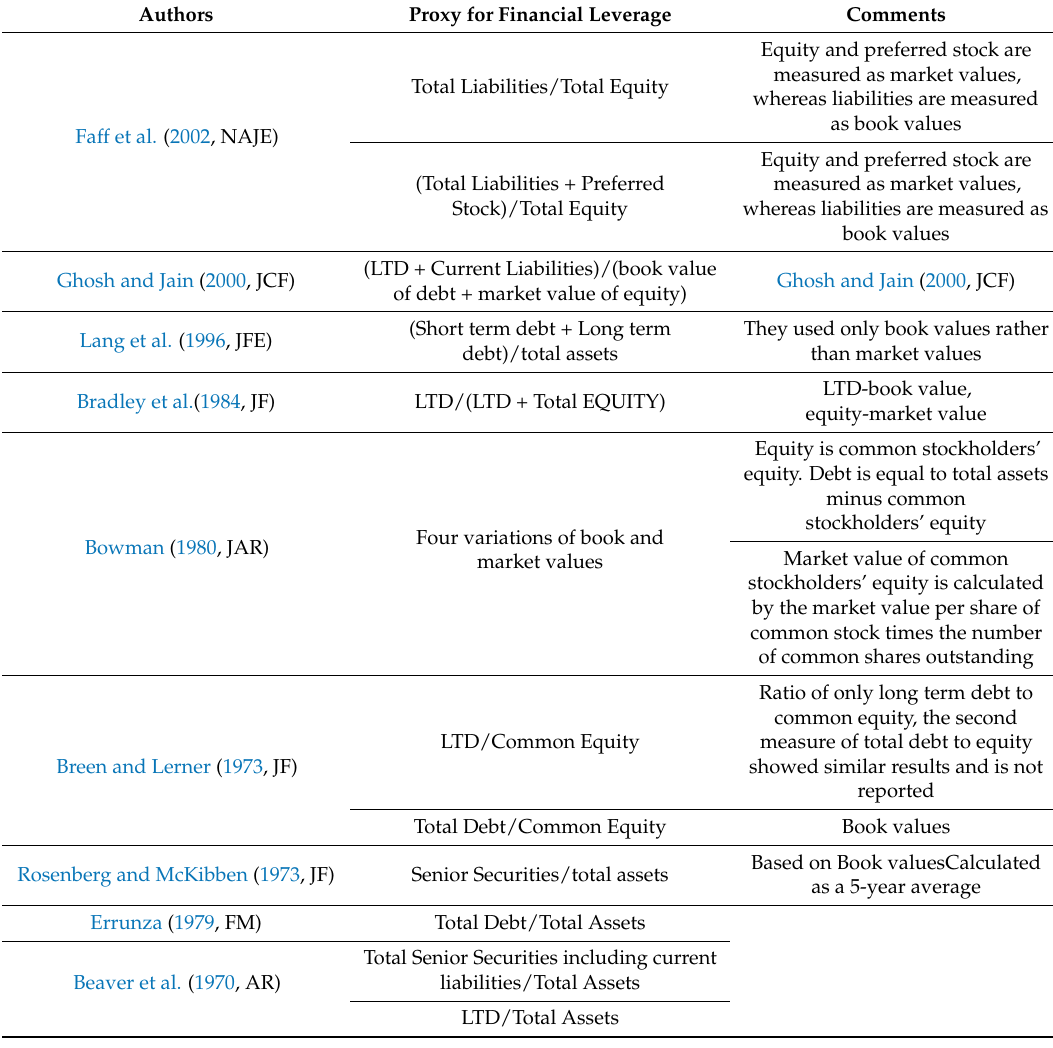
Table A1. Summary of Literature Financial Leverage